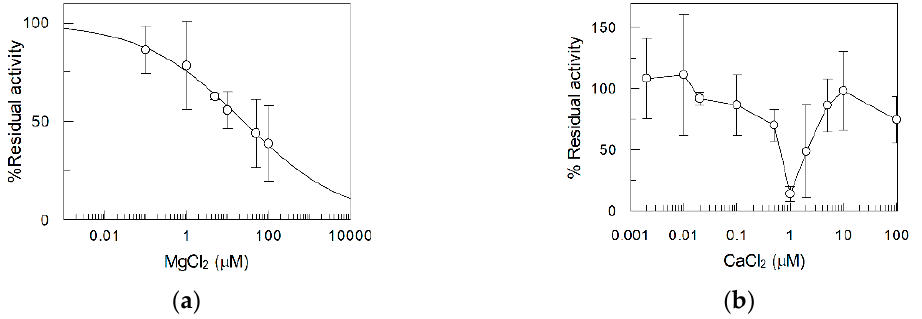
Figure 7. Dose-response curve for the inhibition of RFVT2 transport activity by MgCl 2 ( a ) and CaCl 2 ( b ) . It was obtained adding the divalent ions at the indicated concentrations 1 min before the labeled substrate. Riboflavin transport was stopped after 30 min. The values are means ± SD from three experiments.